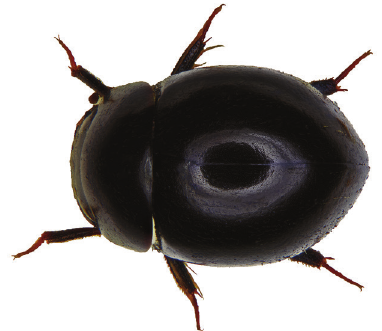
Figure 10. Amphiops globus Erichson, 1843 5.1 mm, iSimangaliso Wetland Park, False Bay (site 27), January 2015 DT Bilton, MS Bird & R Perissinotto leg.